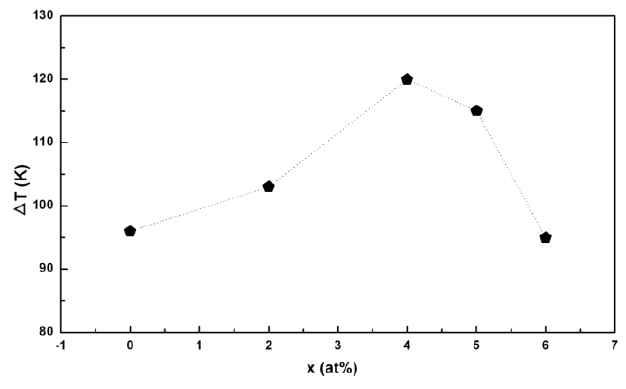
Figure 3. Variation of ∆ T with increasing Si content.